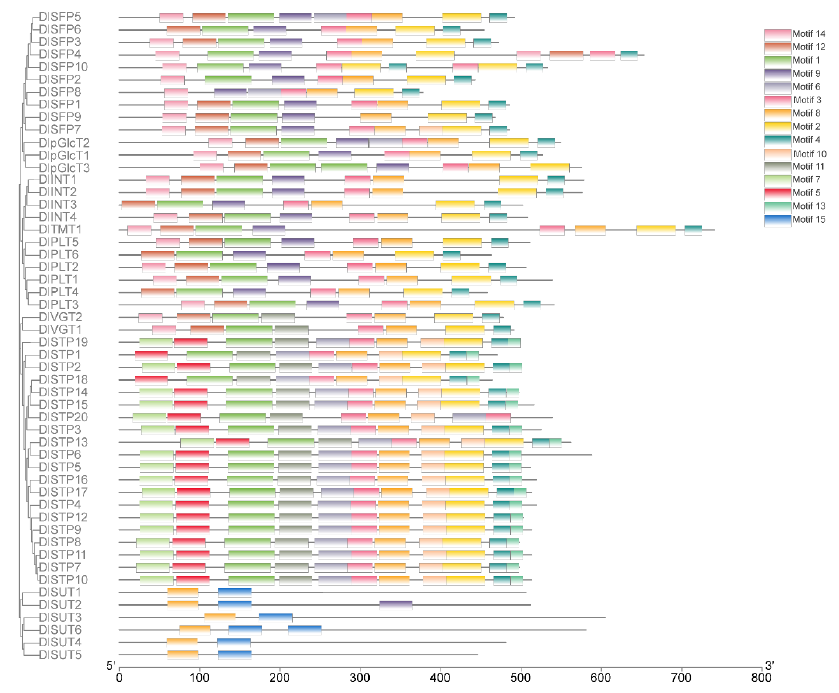
Figure 3. Compositions of the conserved protein motifs of the DlST genes from longan. The sequence information for each motif is provided in Table S1.